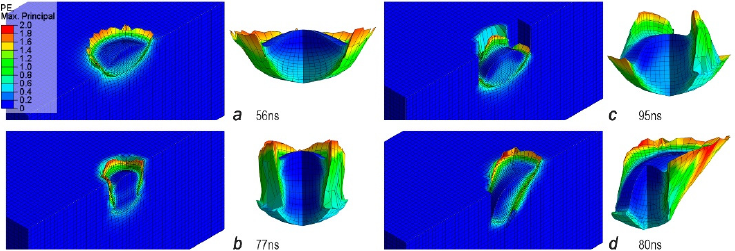
Figure 3. Plastic strain of the particle ( d P = 50 µ m) and the substrate at the end of the collision: ( a ) without microdefect; ( b ) with cube-shaped microdefect; ( c ) with rectangular-shaped microdefect; ( d ) with the particle collision on the edge of cube-shaped microdefect.